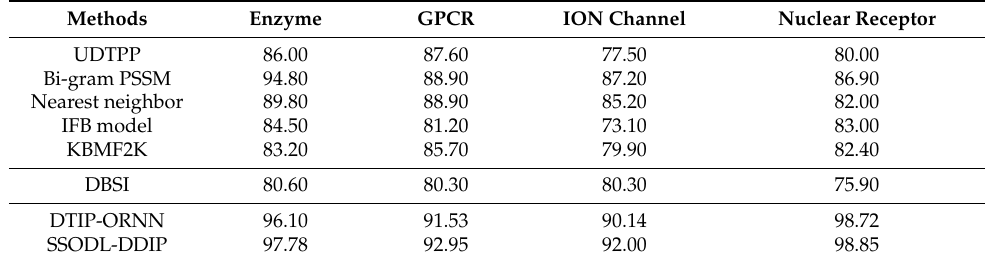
Figure 6. AUPR analysis of the SSODL-DDIP system under different CV_seed values. Table 4. Comparative analysis of the SSODL-DDIP technique on different datasets in terms of AUC.